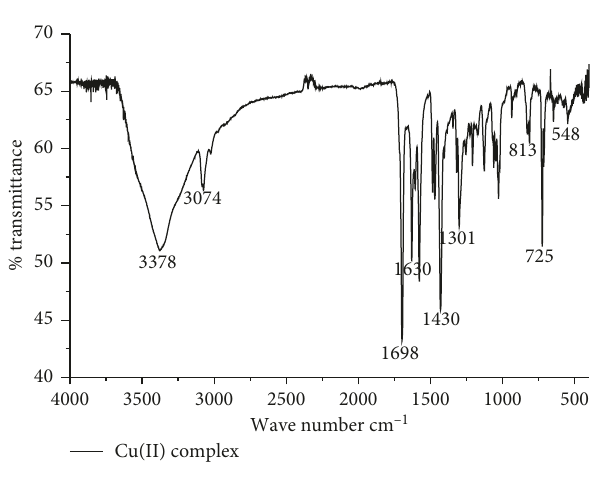
Figure 5: IR spectra of Ni(II) complex.